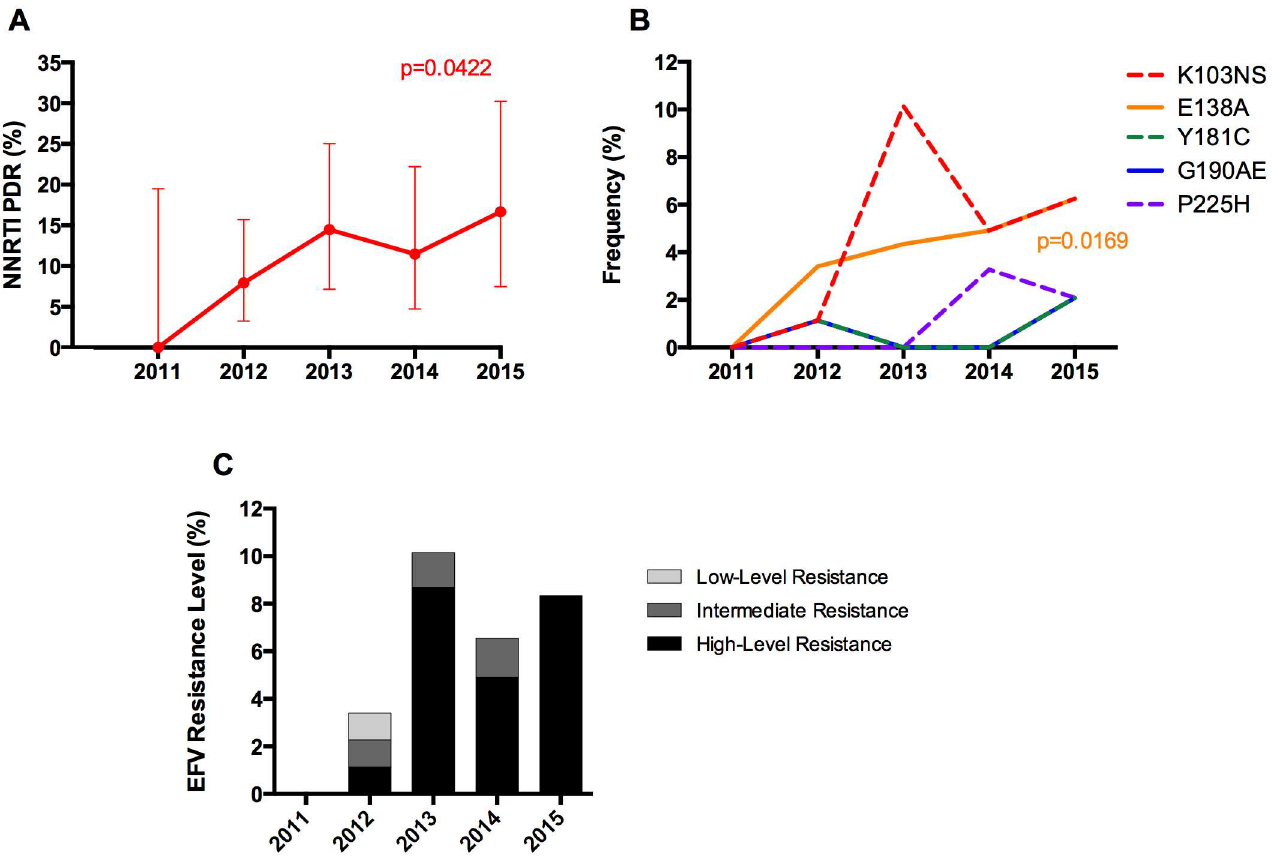
Fig 5. NNRTI PDR trends in Nicaragua. PDR was estimated by year of enrolment using the HIVdb tool from Sanger sequences. Individuals with drug resistance were defined as those with at least low-level resistance (Stanford penalty score (cid:21) 15) to any NNRTI. A. NNRTI PDR temporal trends; lines represent 95% confidence intervals. B. NNRTI PDR mutation frequency trends; only surveillance drug resistance mutations to NNRTI with frequency over 0.5% and E138A are included.C. PDR levels per year for efavirenz; drug resistance levels per year are classified accordingto the Stanford Score, as explainedfor Fig 3. Significant trends are shown; linear regression, slope different to 0; the color corresponds to the significant category. The number of patients enrolledby year was 17, 88, 69, 61, and 48 for 2011, 2012, 2013, 2014, and 2015 respectively.